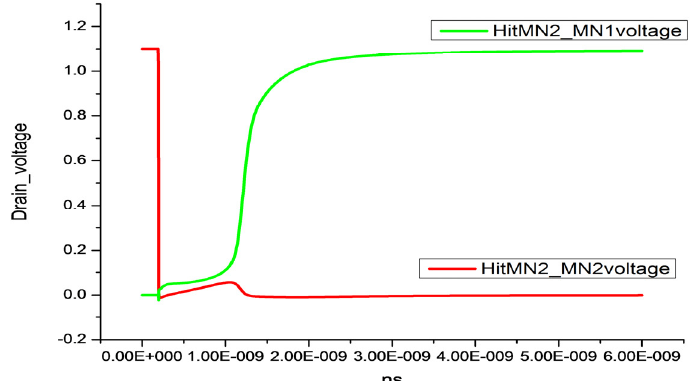
Figure 8. A particle strikes the drain central region of MN2 transistor perpendicularly. Cross-sections of layout in a cell of SRAM.